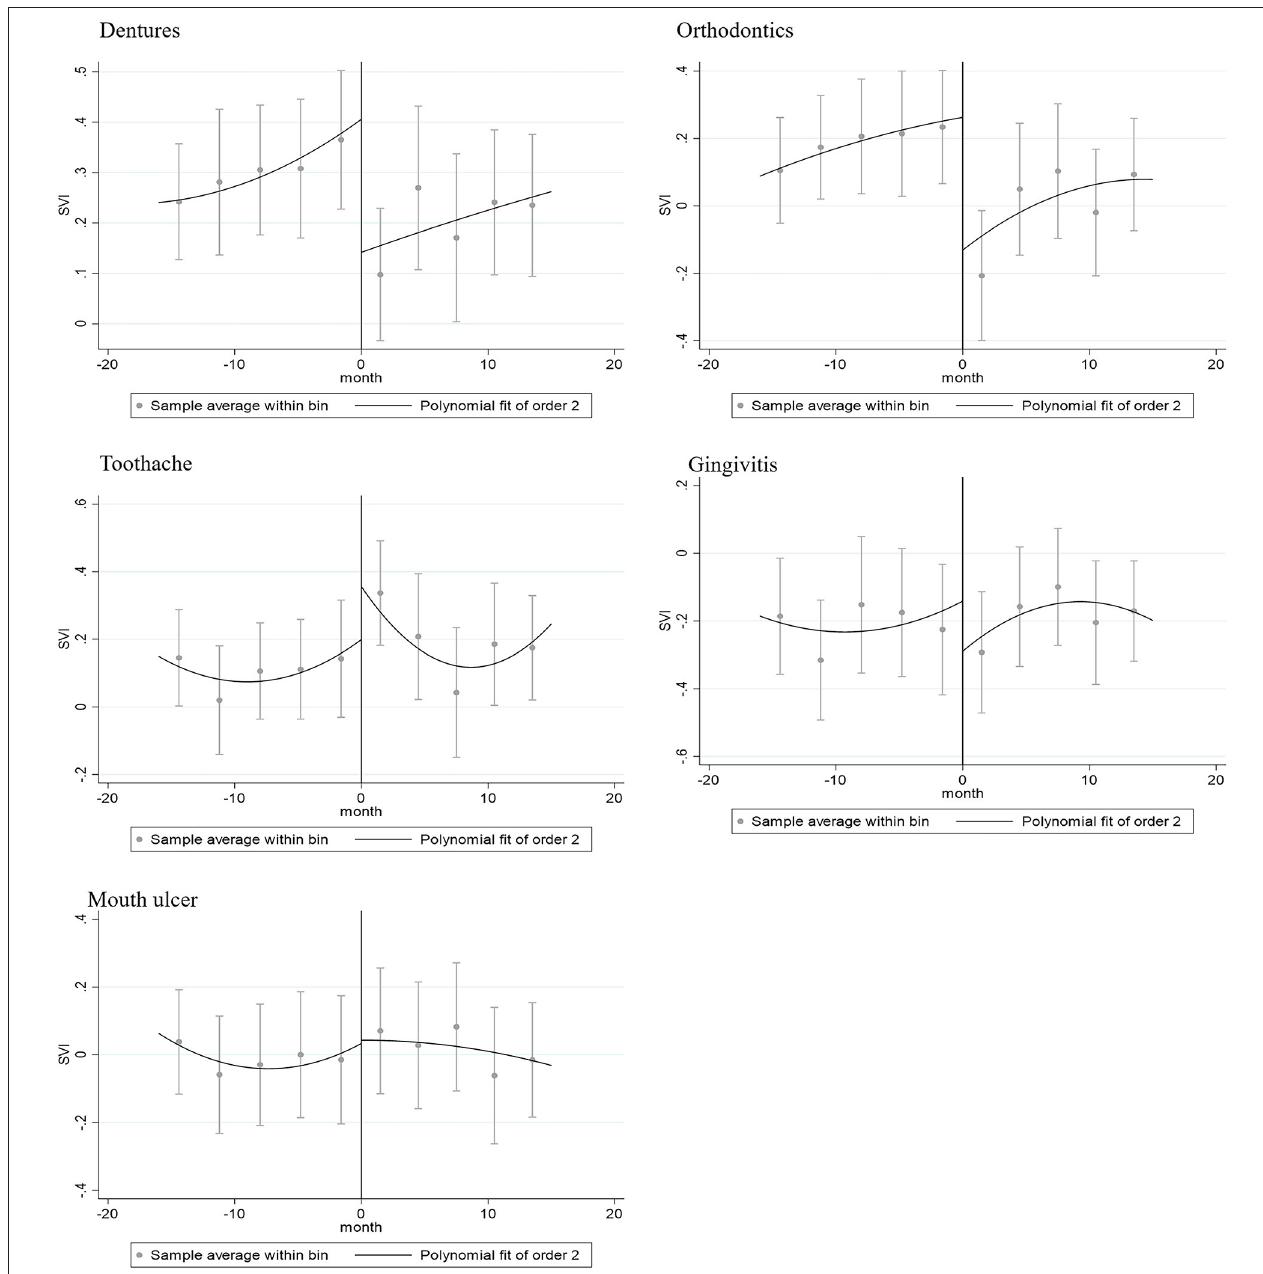
FIGURE 2 | Regression discontinuity plot of topics of dentures, orthodontics, toothache, gingivitis, and mouth ulcer in March 2020.